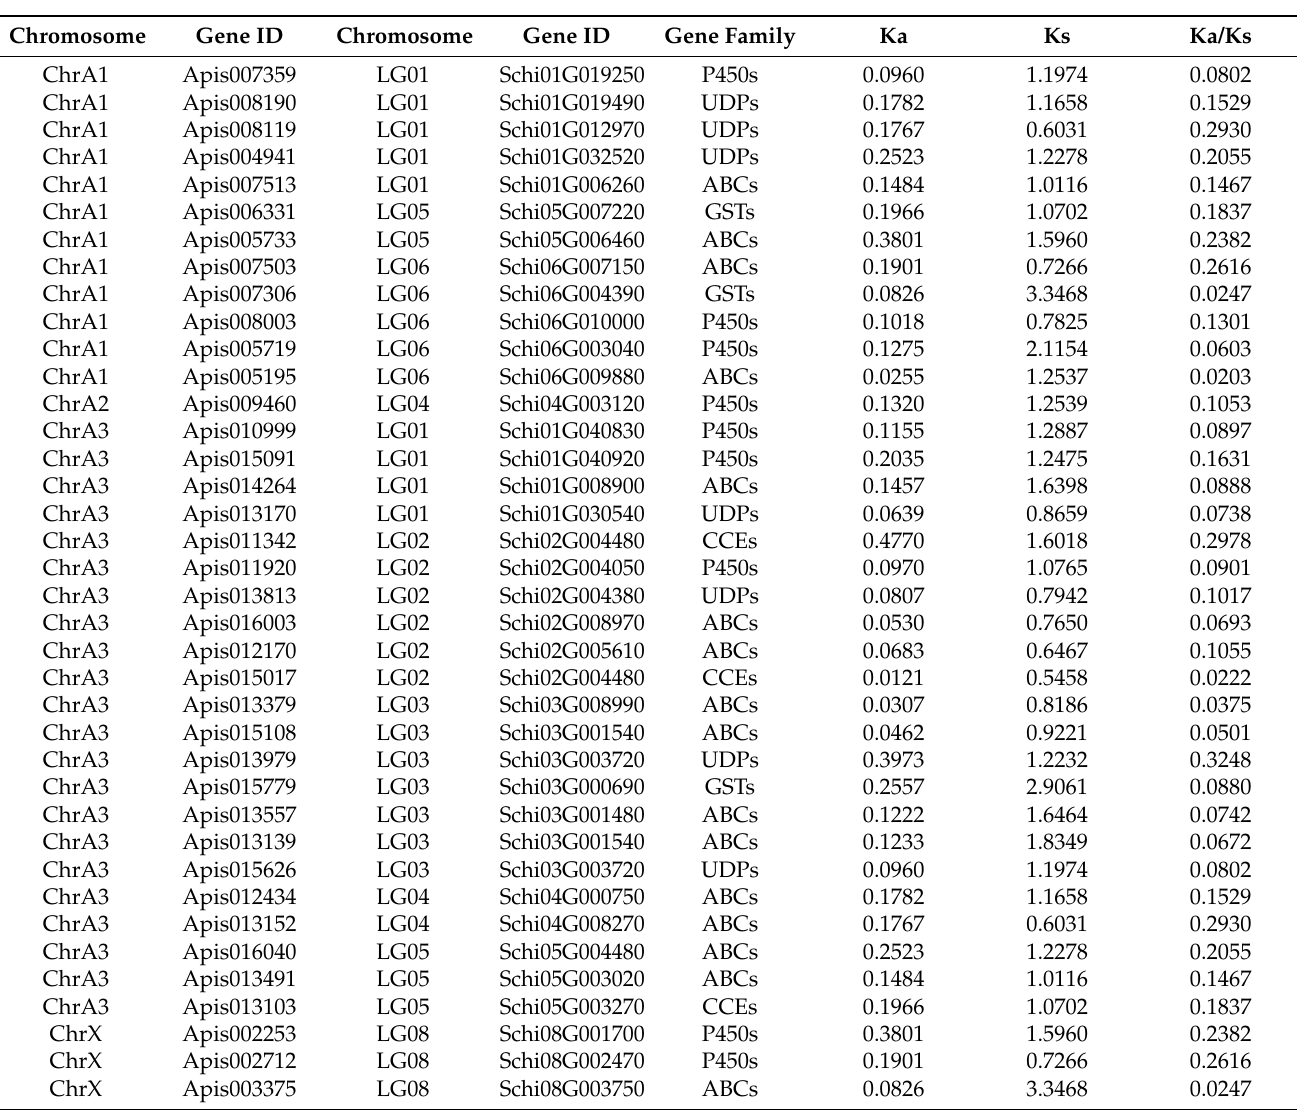
Table 2. Nucleotide substitution rate of detoxification genes in S. chinensis